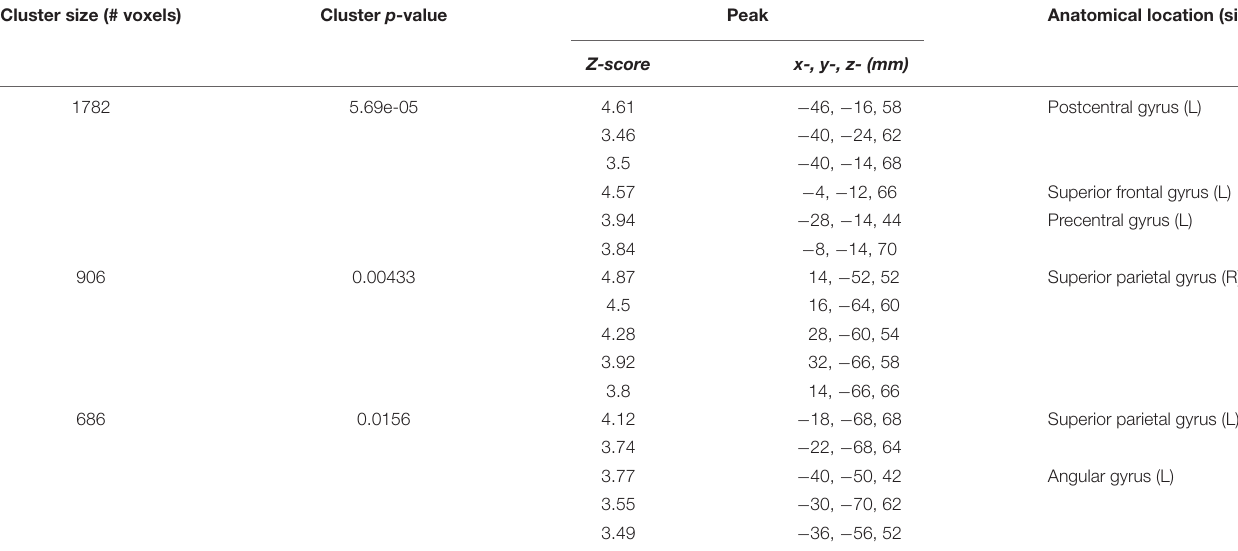
TABLE 4 | Summary of primary fMRI activation clusters that are associated with immediate retention performance. Cluster size (# voxels) Cluster p -value